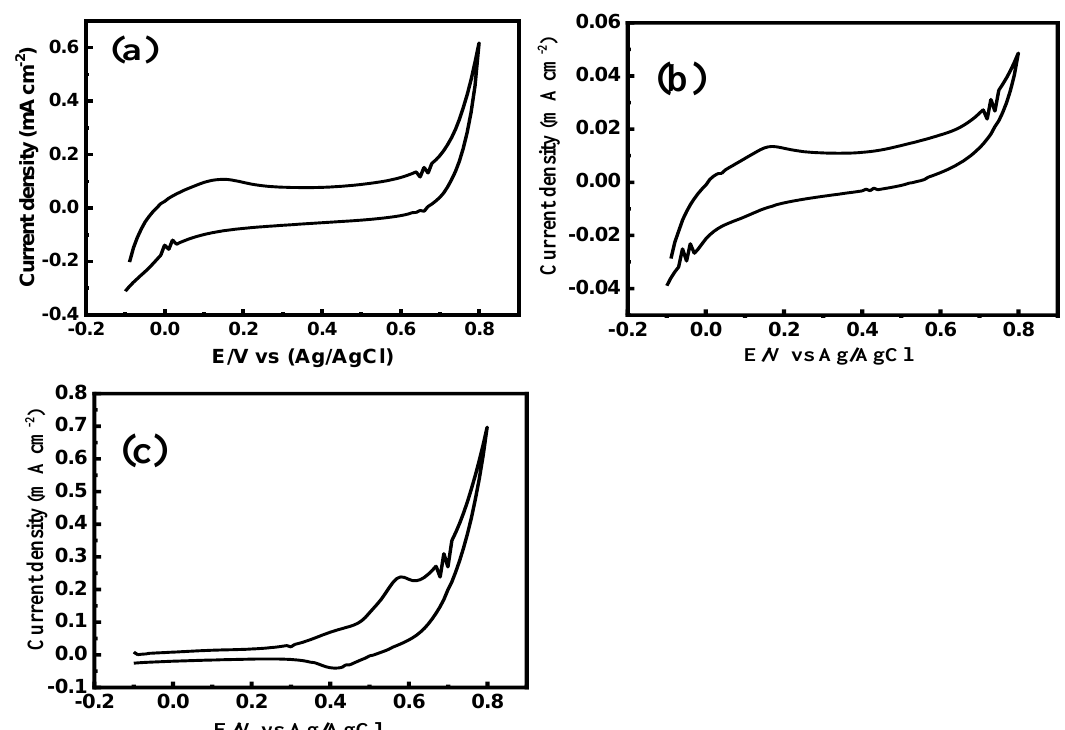
Figure 3. ( a ) CV of the enzymatic CuNi-MC in sweat solution after adding glucose of 0.11 mM at pH 7. The CV of CuNi-MC in sweat solution ( b ) before ( c ) after the addition of the glucose oxidase (0.11 mM) at pH 12. For all measurements, a scan rate was 50 mV s −1 .